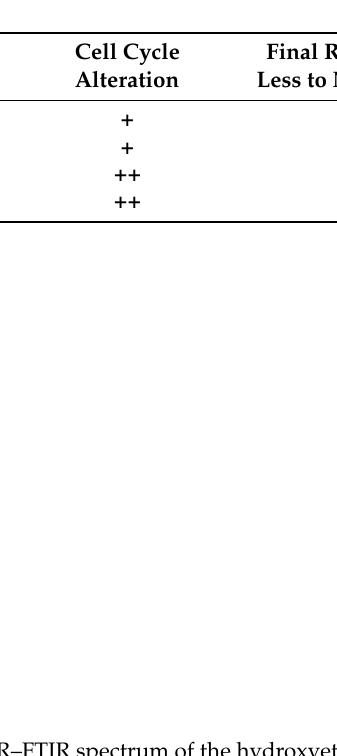
Table A1. Summary of the toxicological outcomes and tentative ranking of the tested NPs from the less to the most toxic. Scores (in terms of number of +) were assigned considering the statistical significance of the effects, the dose response tendency of the effects and the first concentration of exposure giving a significant effect.